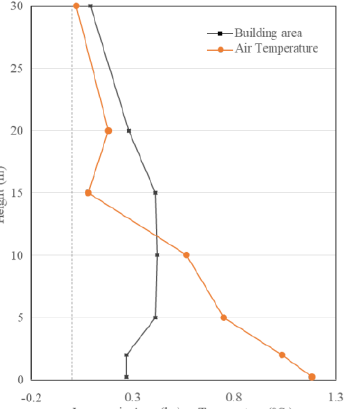
Figure 11. Increase in total building area and the corresponding increase in air temperature per atmospheric height in Subsite